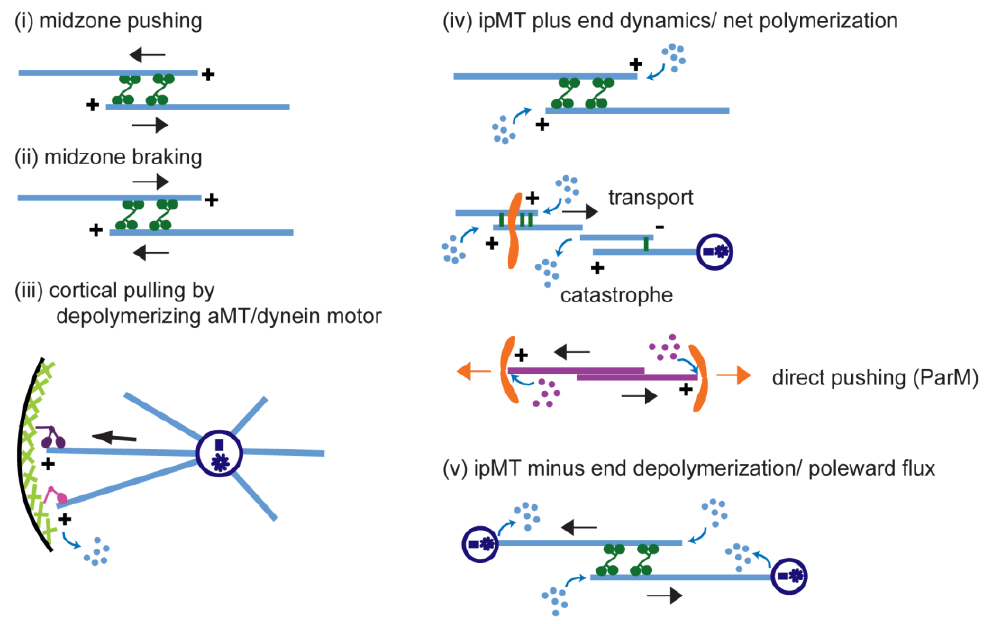
Figure 5. Anaphase B modules. The five biochemical modules depicted in Figure 2 (modules i–v ) that are deployed to various extents in different systems are shown in more